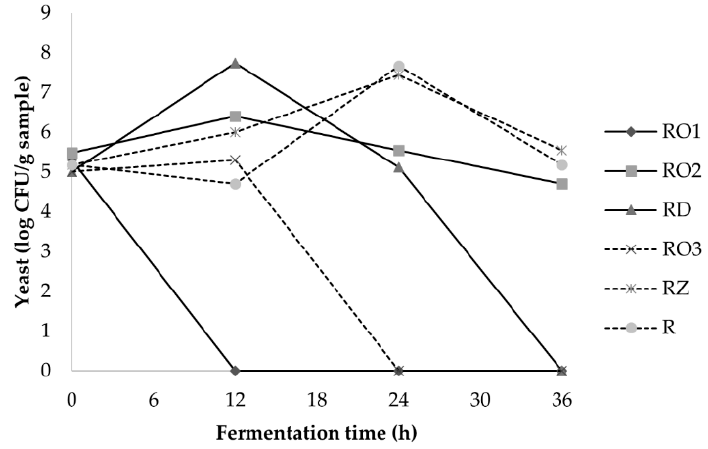
Figure 4. Yeast population during fermentation of soybean with various Rhizopus strains.